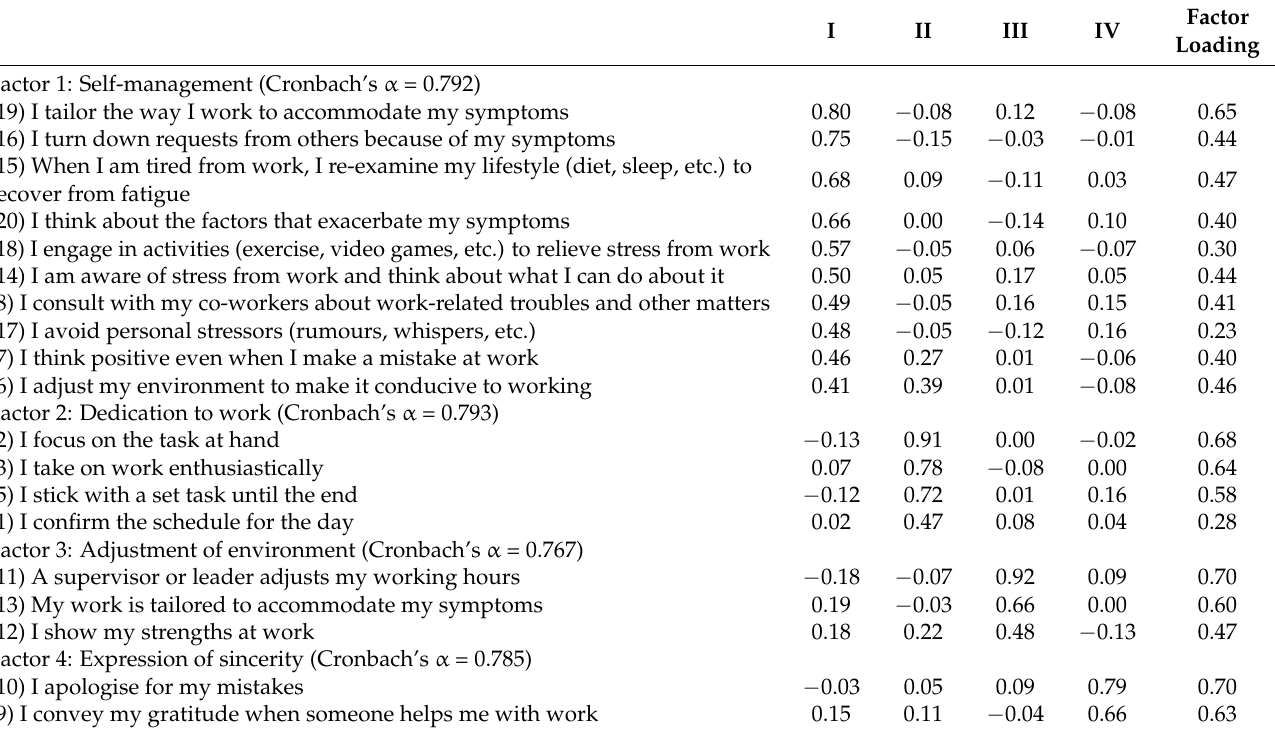
Table 3. Continued Employability Scale factor analysis results (factor pattern following promax rotation)